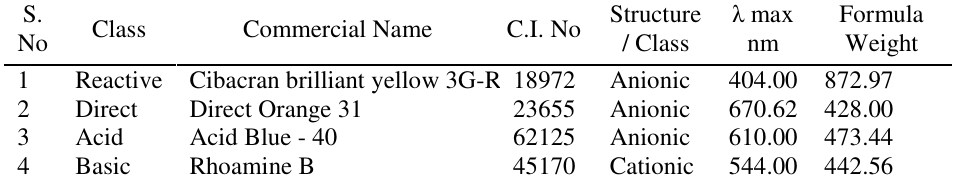
Table 7. Selected dyes and their characteristics taken from colour index.